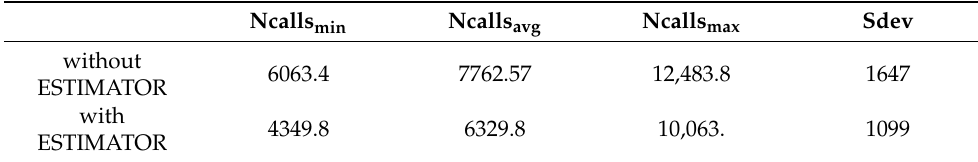
Table 5. Objective function’s calls number over 30